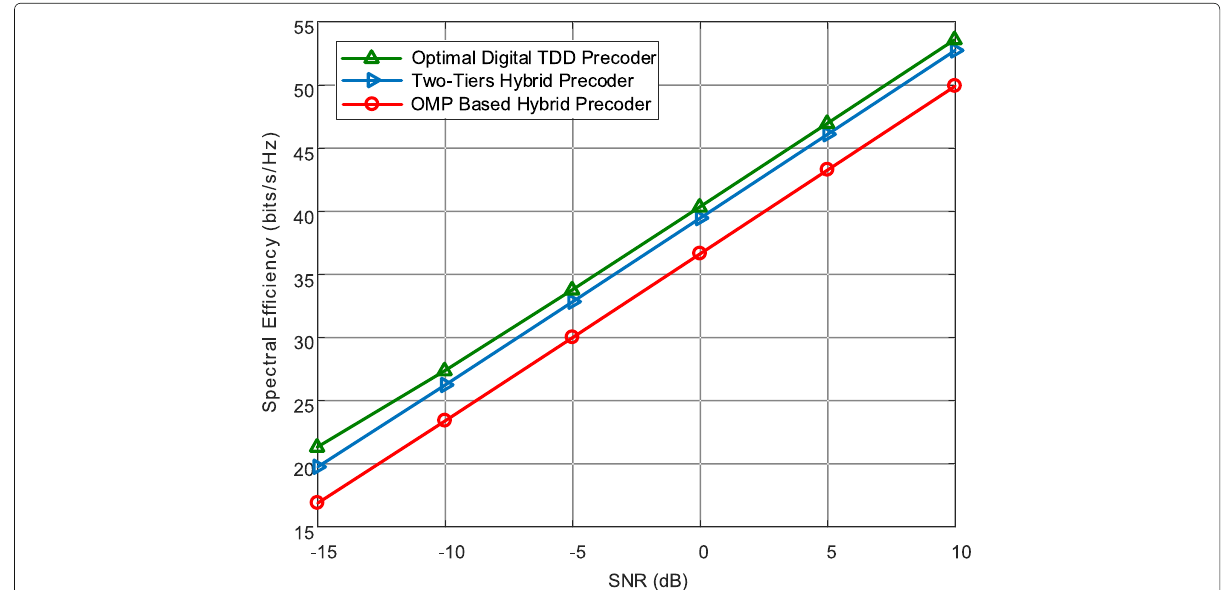
Fig. 4 Spectral efficiency achieved by different precoding schemes in single-user mmWave MIMO-OFDM systems with N t = 256, N r = 64, total bandwidth B = 1.2 GHz, f c = 60 GHz, N t